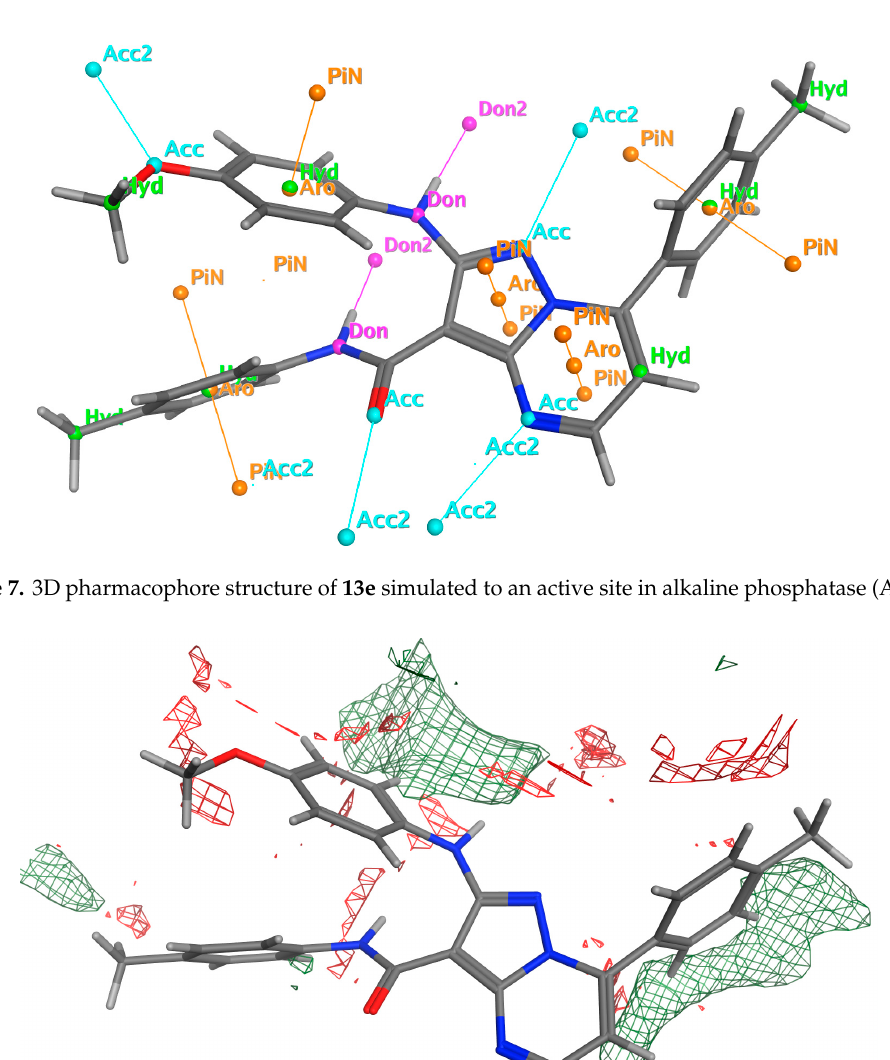
Figure 6. 2D interaction diagrams of compound 13e with alkaline phosphatase (ALP).